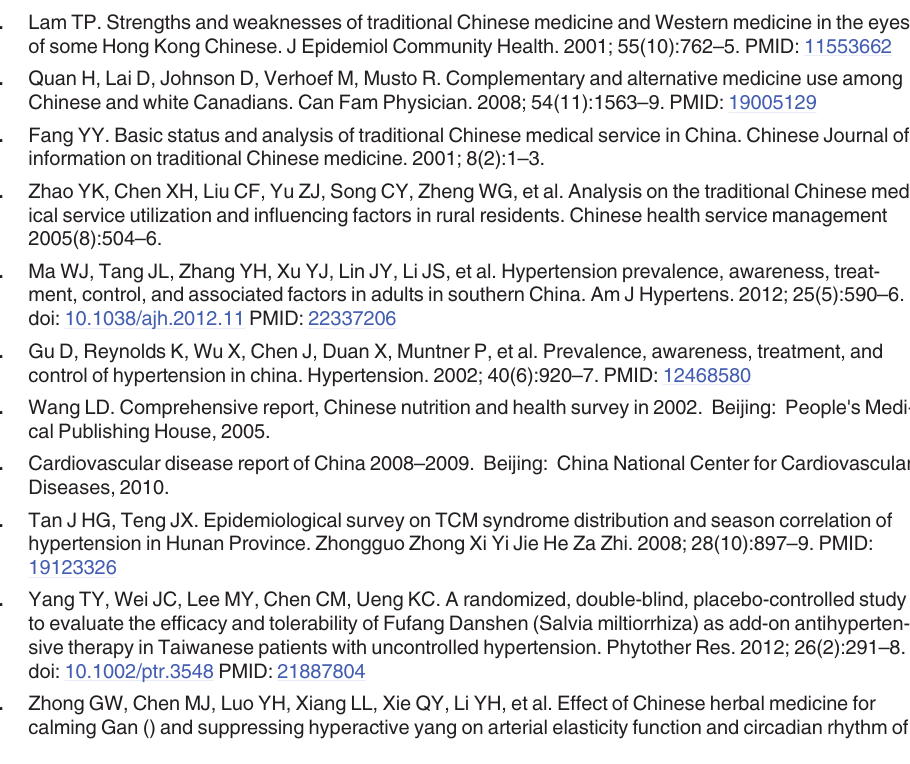
S1 Table. SAS statistics process for Tables 1 – 4. S2 Table. SAS statistics process for Table